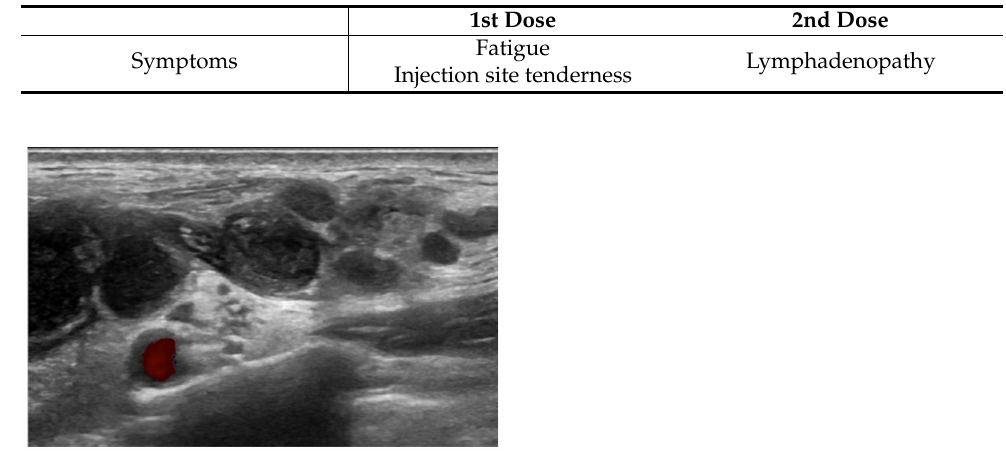
Figure 1. Clinical photograph of a 66-year-old female patient with enlarged lymph node in left supraclavicular region ipsilateral to the COVID-19 vaccine injection site. Table 1. Side effects after 1st and 2nd dose of ChAdOx1 COVID-19 vaccine in case patient.